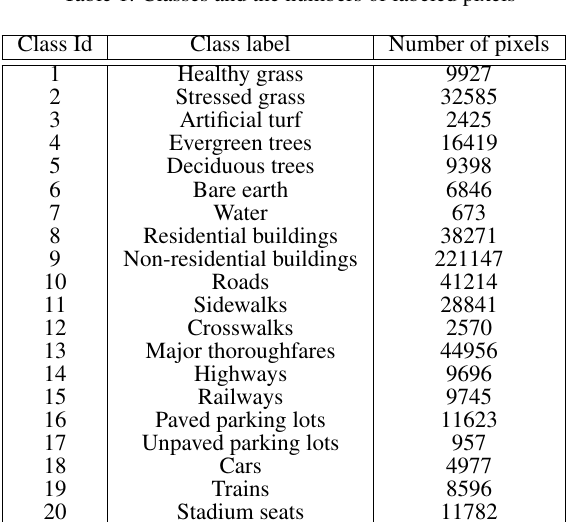
Table 1. Classes and the numbers of labeled pixels